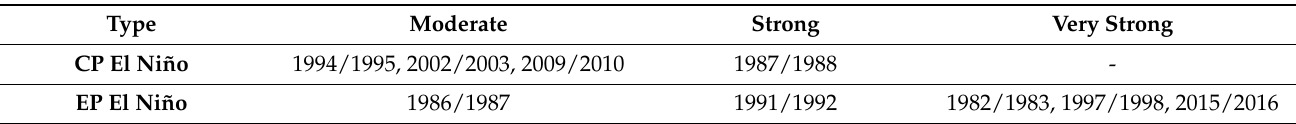
Table 1. El Niño events ranging from moderate to very strong from 1978 to 2017 and their classification based on the Niño methods.